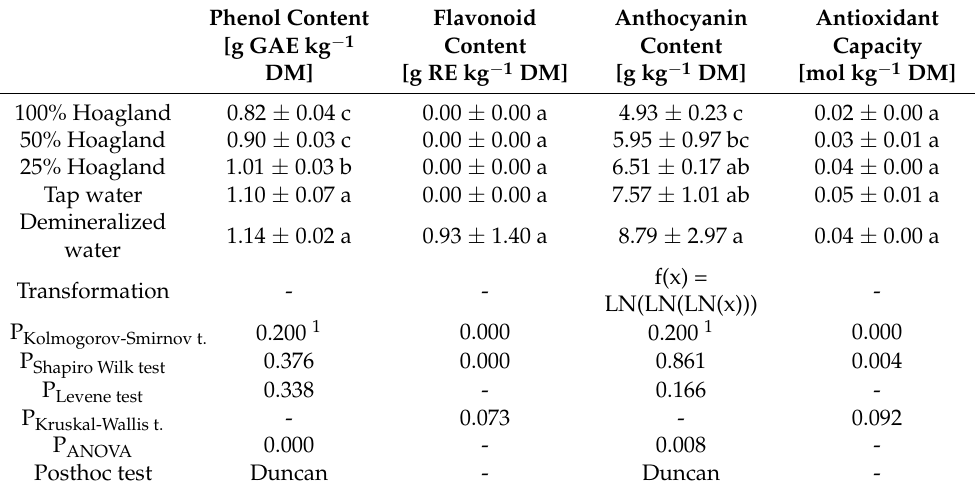
Table 11. Content of phenolic compounds and antioxidant capacity in the stems of radish cress in g kg − 1 dry mass (DM) and mol kg − 1 DM, respectively. Different letters within a column indicate significant differences.